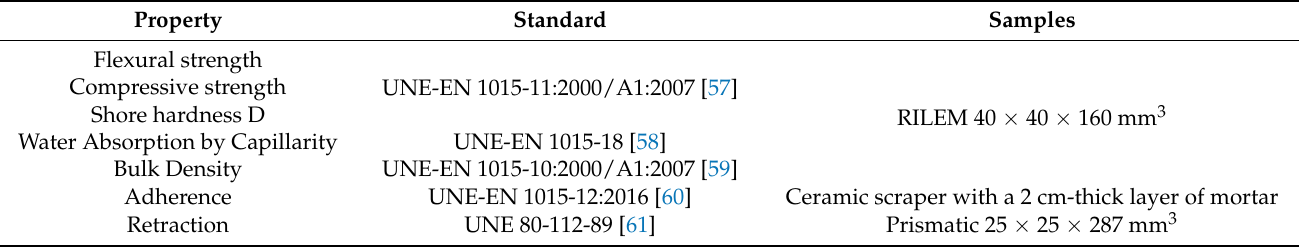
Table 7. Physical and mechanical characterization tests performed.